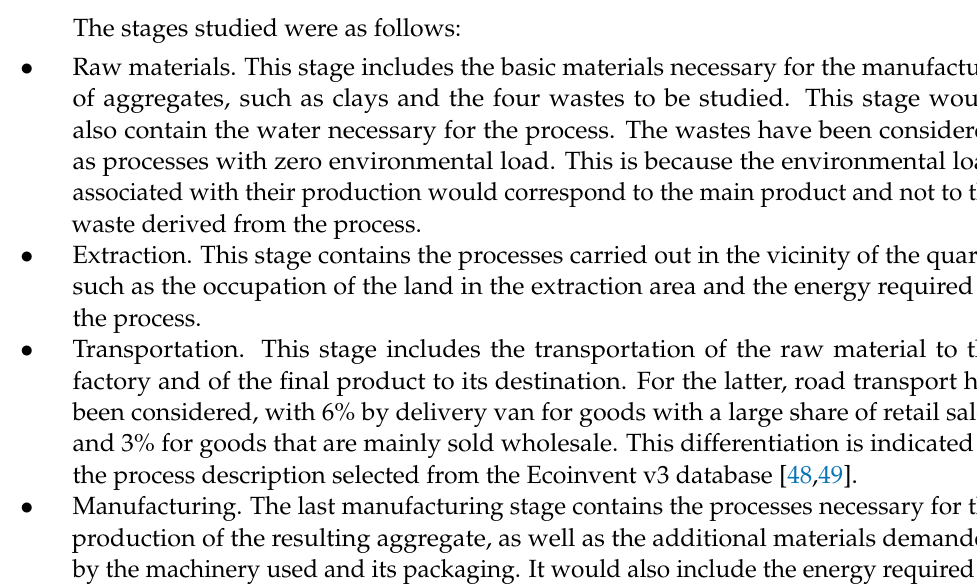
Figure 1. Artificial lightweight aggregate production scheme and system boundaries considered.